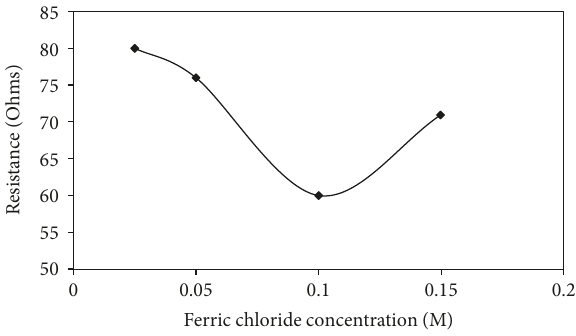
Figure 4: Resistance versus di ff erent ferric chloride concentrations (pyrrole 0.05M at 25 ° C, duration 4hrs, and surfactant 0.025M).